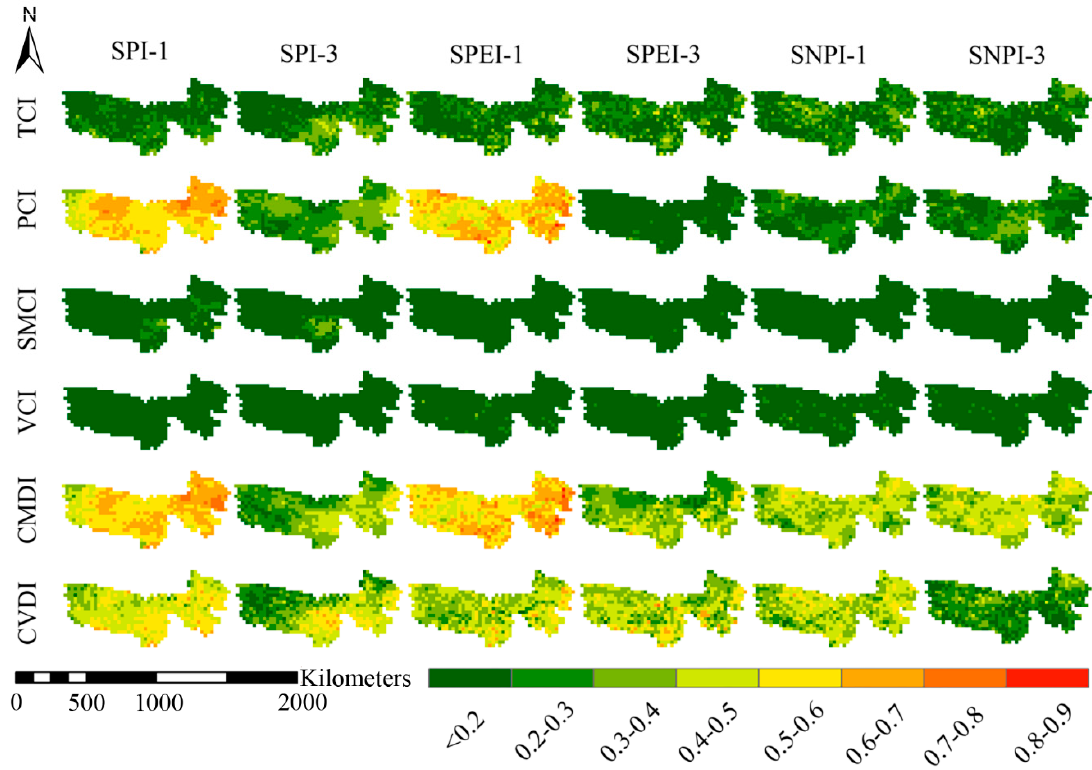
Figure 6. Monthly correlation coefficients between the CI-based drought indices and in situ drought indices.